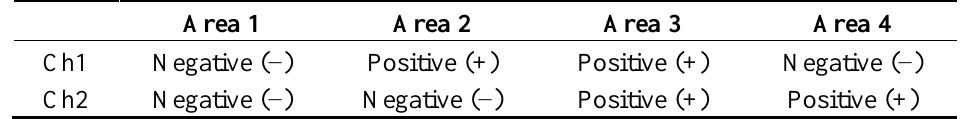
Table 1. Combinations of EOG